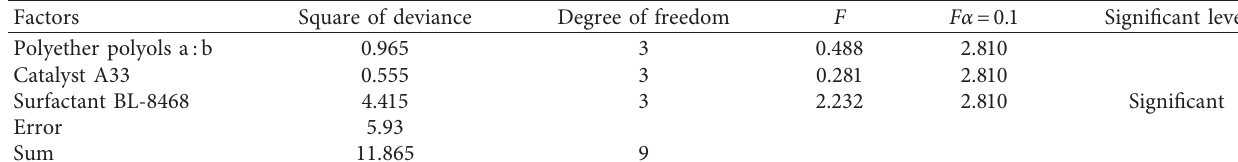
Table 6: Variance analysis results of expansion ratio.